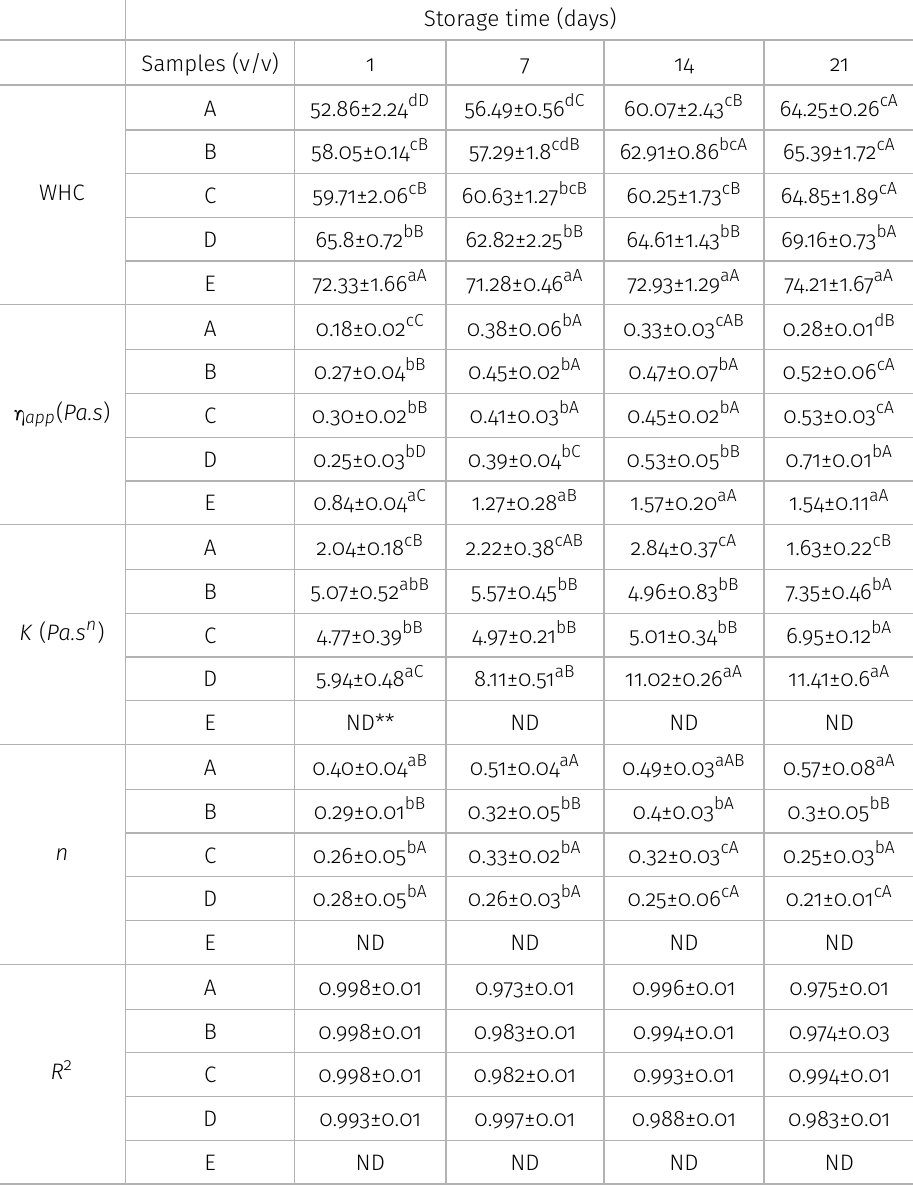
Table II. Water holding capacity (WHC) and rheological properties of yoghurt-like product produced with cow milk and hazelnut beverage during storage at 4